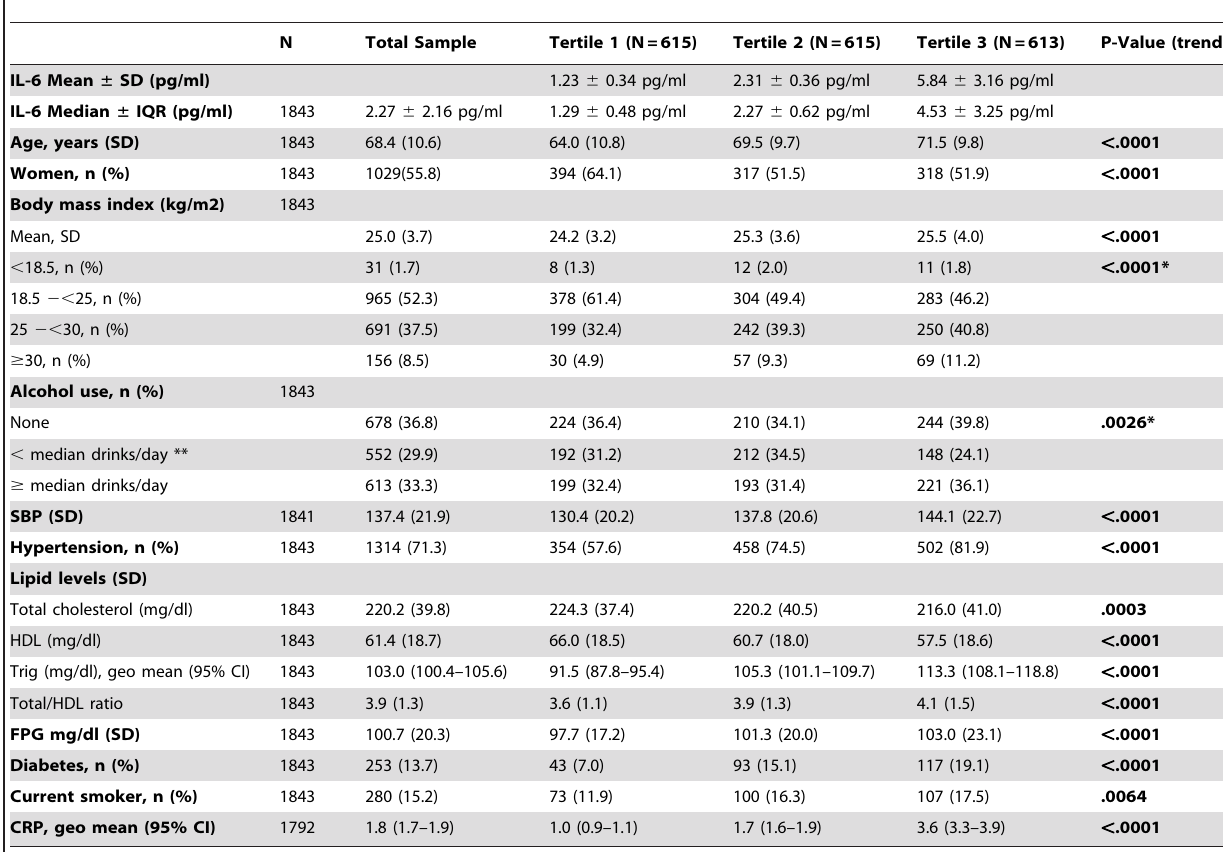
Table 1. Baseline characteristics of participants based on tertiles of IL-6 in the Rancho Bernardo Study